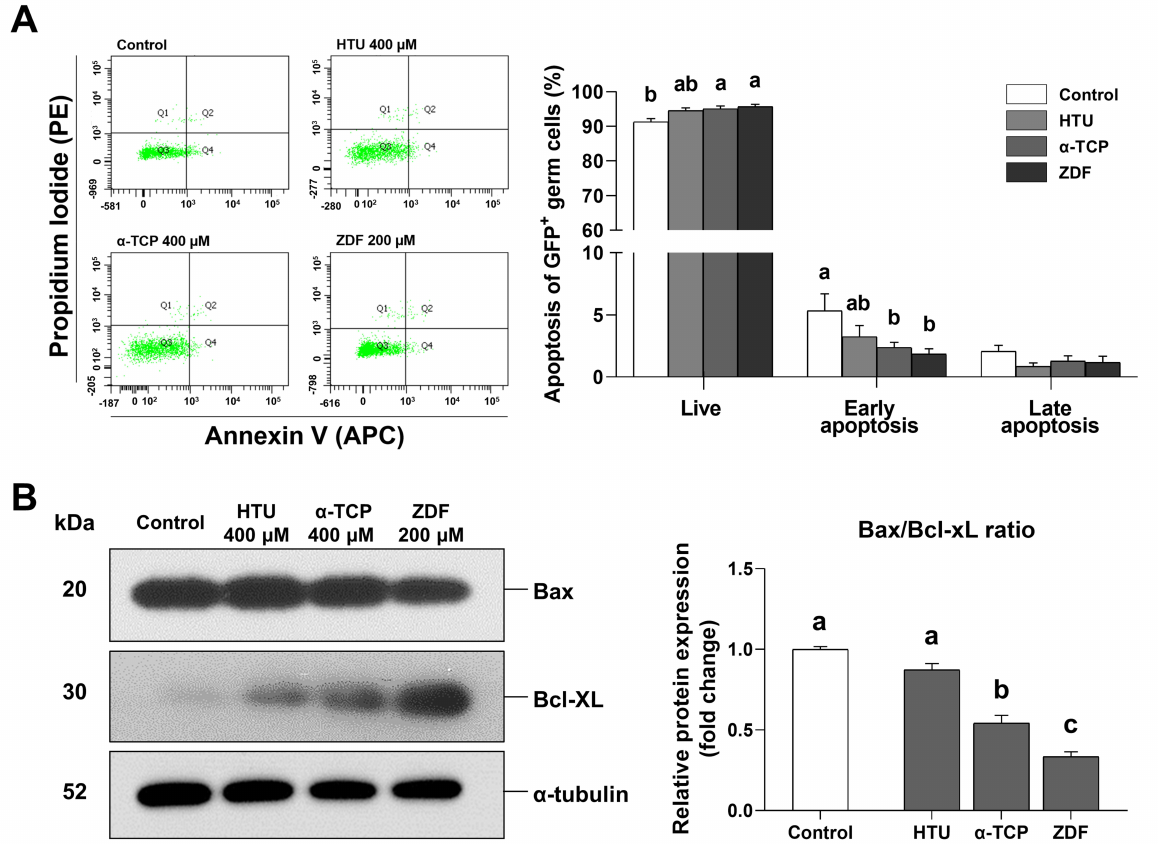
Figure 3. Apoptosis of frozen germ cells after post-thaw recovery with antioxidant or apoptosis inhibitor supplementation. ( A ) Early and late apoptosis in the HTU 400 µ M, α -TCP 400 µ M, and ZDF 200 µ M treatment groups. Apoptosis was evaluated 12 h after post-thaw recovery in cryo-thawed germ cells. The apoptotic cell population is summarized in a graph. ( B ) Bax/Bcl-xL ratio determined using western blot analysis. α -Tubulin was used as a loading control. The graph represents the quantification of protein expression, which was measured as the fold change of the treatment groups with respect to the control. The values are expressed as mean ± SEM ( n = 3). Statistical analysis was performed using one-way ANOVA coupled with Tukey’s post-hoc test. Different letters above each column indicate statistically significant differences ( p < 0.05). HTU, Hypotaurine; α -TCP, α -tocopherol; ZDF,